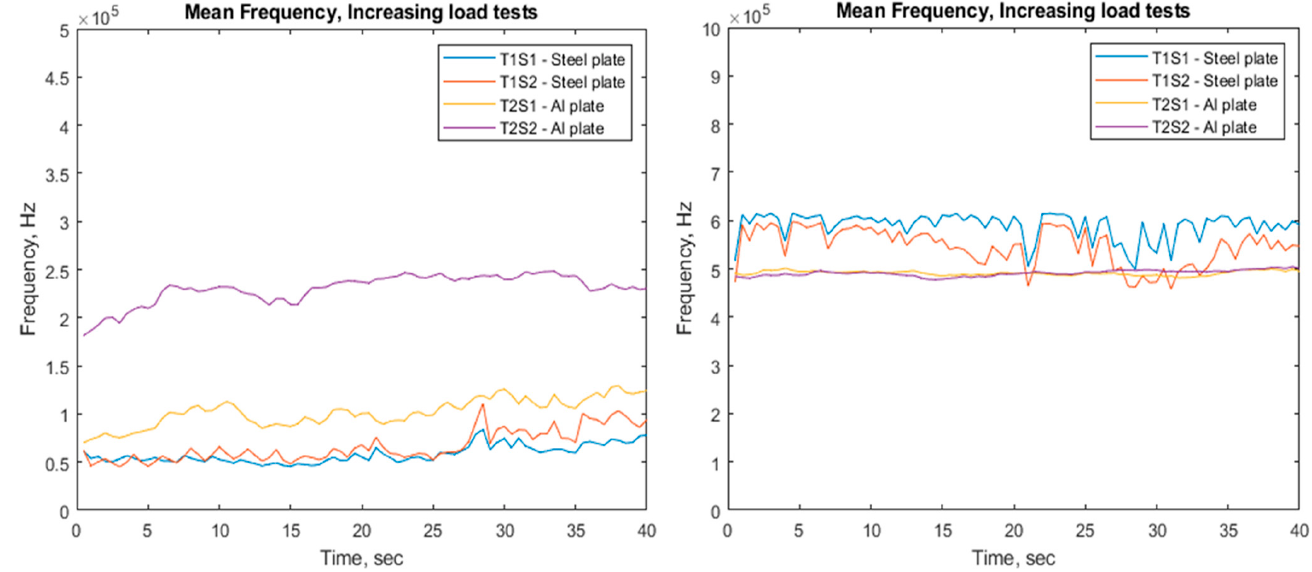
Figure 10. (Left) Mean frequency across test of tool steel indenter on tool steel sheet and tool steel on aluminium sheet under increasing load, including the sub-300 kHz region. (Right) Mean frequency of same increasing load tests with 300 kHz high pass filter applied.